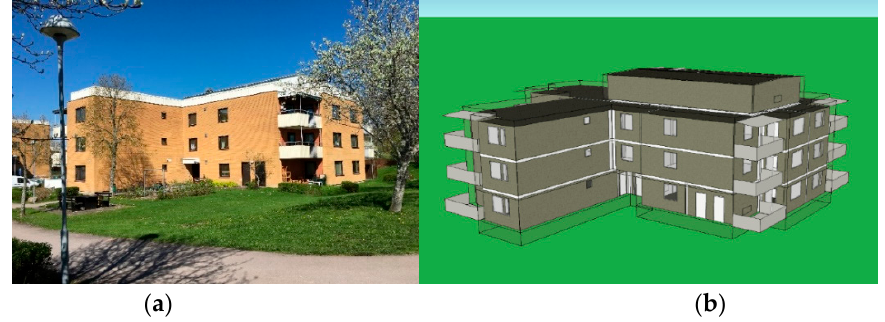
Figure 1. ( a ) Building that was modeled. ( b ) Model of the building in IDA-ICE (IDA Indoor Climate and Energy). Table 2. Technical data of the modeled building.